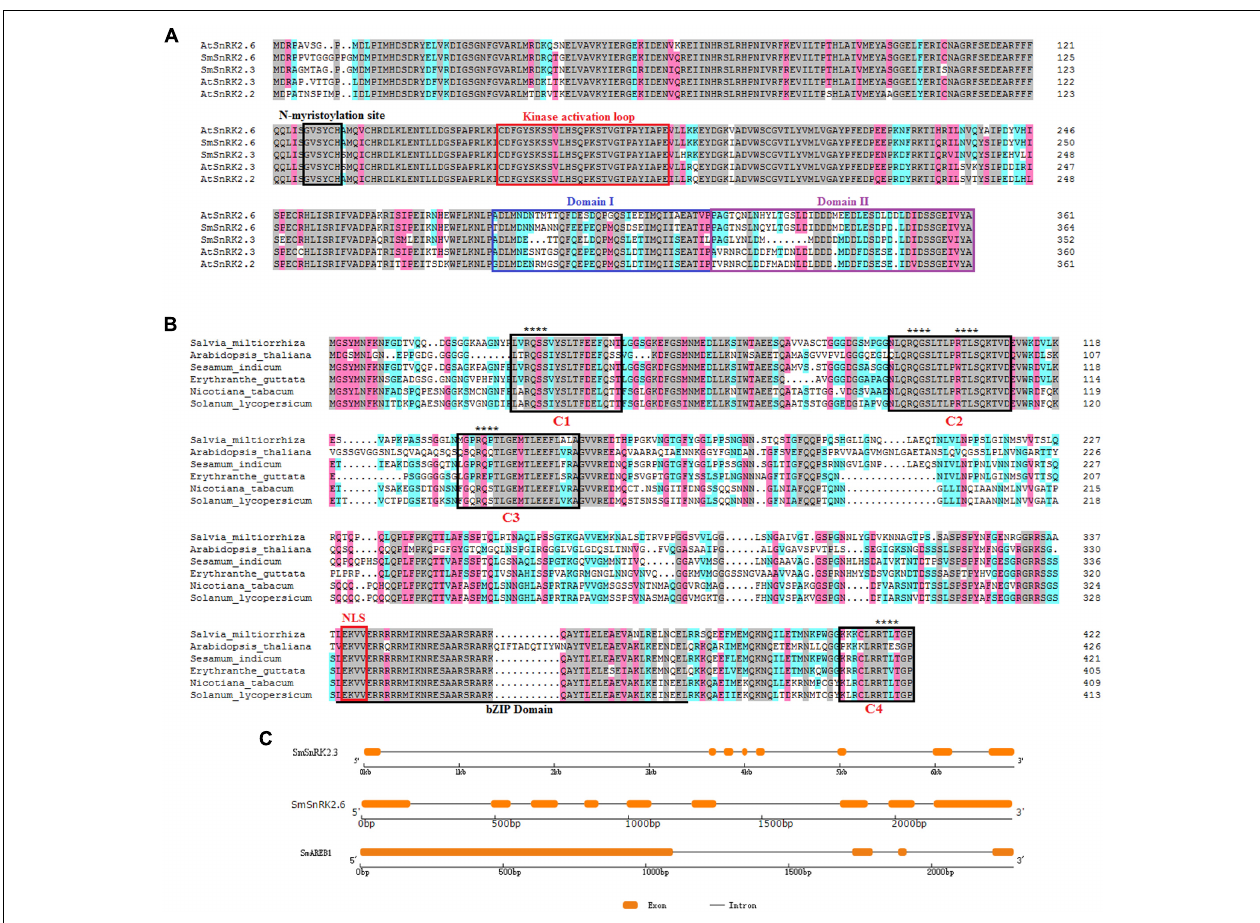
FIGURE 1 | Sequence analysis of SmSnRK2.3 , SmSnRK2.6 , and SmAREB1. (A) Multiple alignments of the deduced amino acid sequences of SmSnRK2.3 and SmSnRK2.6 with AtSnRK2.2, AtSnRK2.3, and AtSnRK2.6 from Arabidopsis thaliana (At). The regions of the N -myristoylation site, kinase activation loop, domain I, and domain II are boxed in black, red, blue, and violet, respectively. (B) Multiple alignment of the deduced amino acid sequence of SmAREB1 and the counterpart protein from other plants. The conserved C1, C2, C3, and C4 domains are boxed in black; the bZIP region is underlined; the NLS domain is boxed in red. The potential five phosphorylation recognition motifs (RXXS/T) are denoted with asterisks ( ∗ ). All multiple alignments were performed using DNAMAN. (C) The positions and length of exons and introns of SmSnRK2.3 , SmSnRK2.6 , and SmAREB1 are displayed schematically. Rounded rectangles indicate exons, while black lines indicate